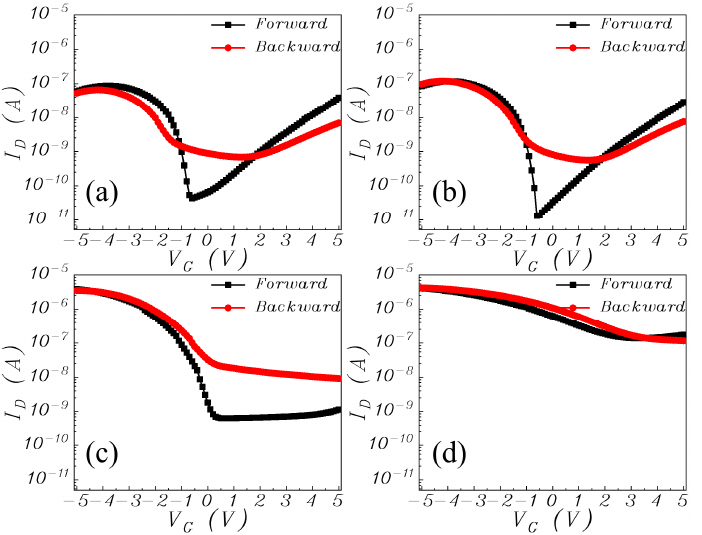
Figure 4. Transfer characteristics of the OTFTs with increasing Ti content in gate dielectric: ( a ) sample A, ( b ) sample B, ( c ) sample C, and ( d ) sample D.